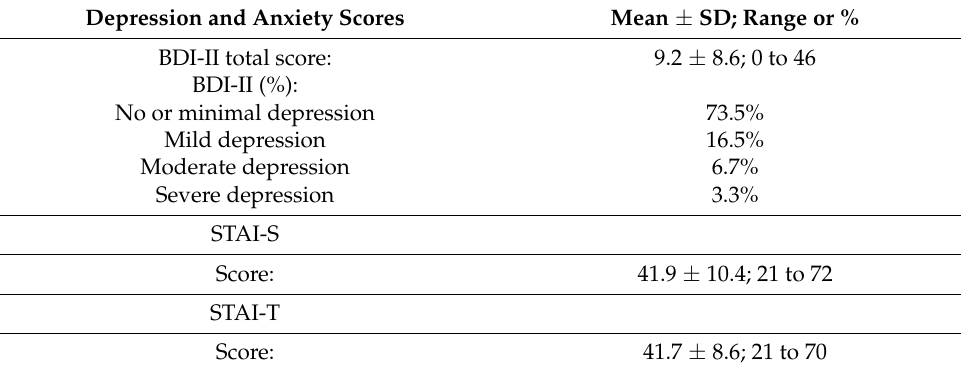
Table 2. The prevalence of depression and anxiety symptoms among the study group. Depression and Anxiety Scores Mean ± SD; Range or % BDI-II total score: